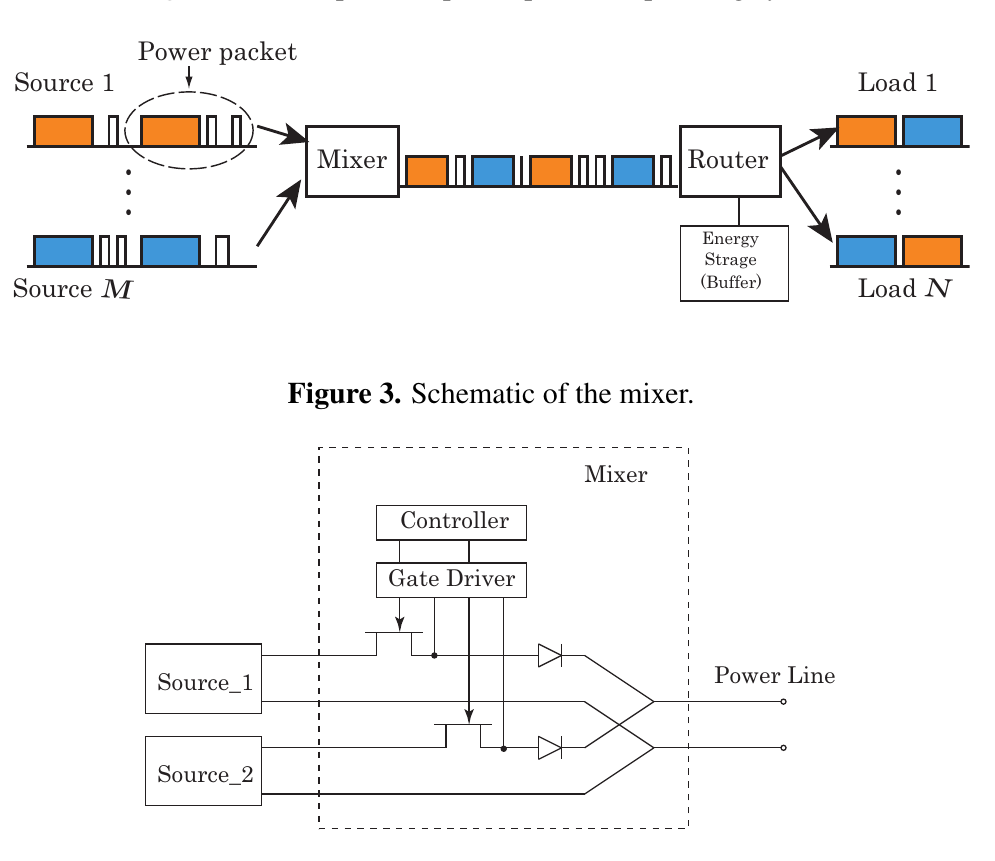
Figure 2. Concept of the power packet dispatching system.